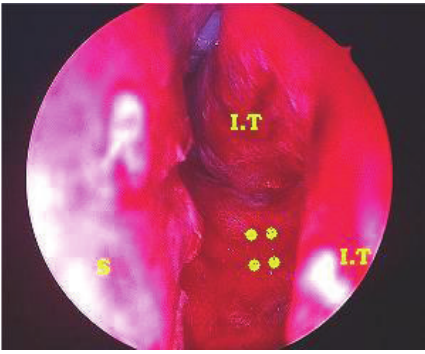
Figure 3: Rhinoscopy view after removal of rhinolith (IT: inferior turbinate, S: septum; yellow spots represent the site of rhinolith).